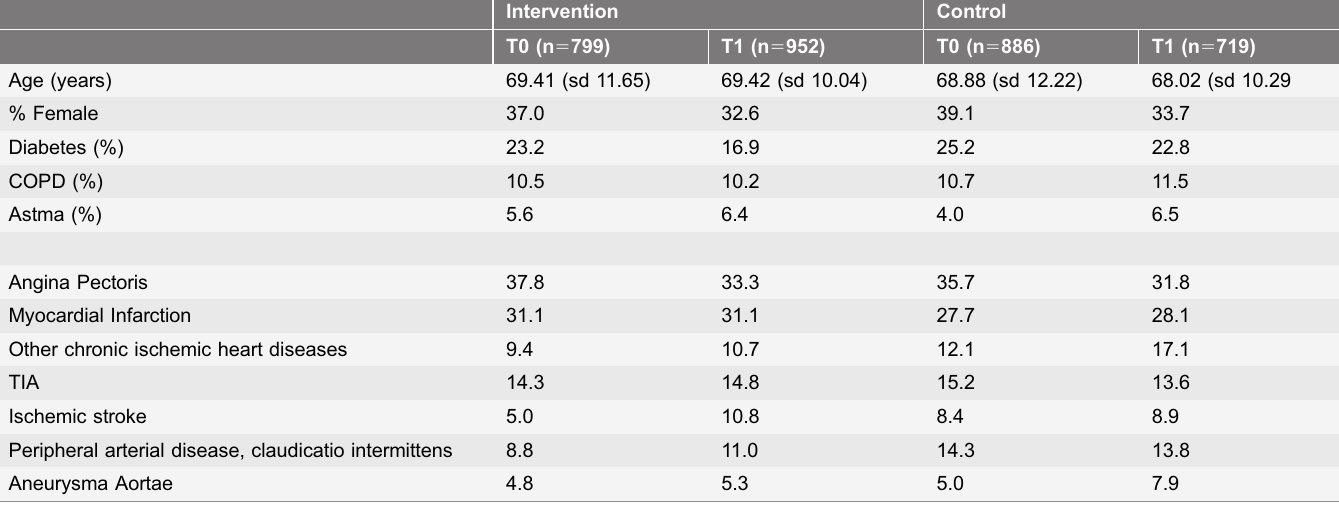
Table 2. Characteristics of Patient Population, Intervention versus Control